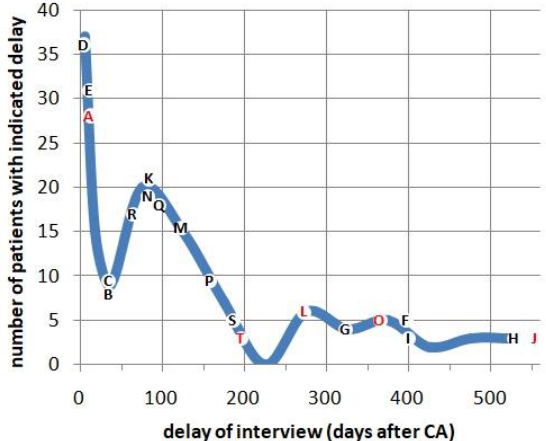
Figure 1. Frequency distribution of interview delay. Interviews were conducted a few days up to 588 days after the CA. The thick line represents all 126 cases. The delay was short for 61 (48.4%), middle for 42 (1/3), and long for 23 cases (18.3%). Cases with detailed recollections (capitals A – T) were slightly more often associated with long delays (χ 2 6.66, 0.025 < p < 0.05). Capitals in red: ≥7 Greyson points.